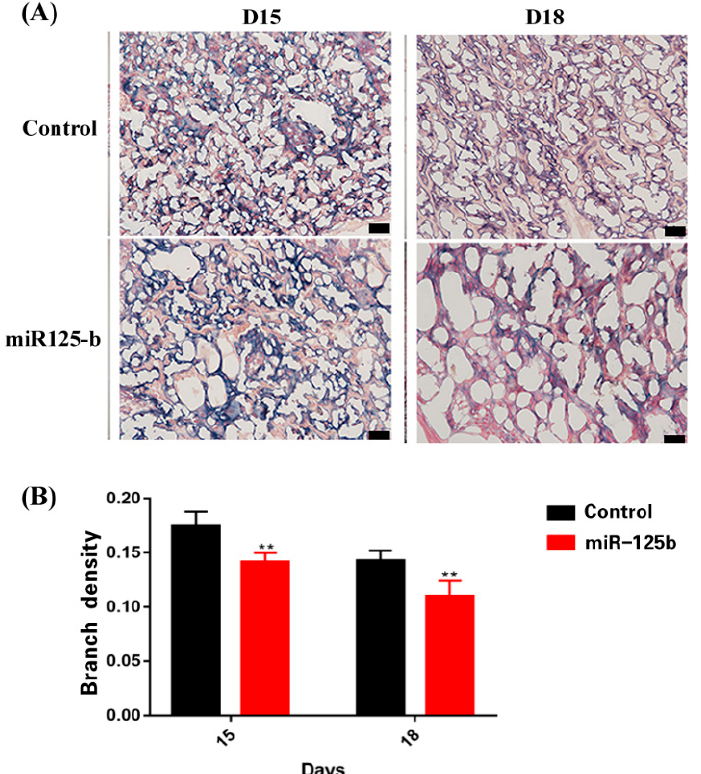
Figure 4. AP staining of placenta ( A ): AP staining of placenta on day 15 and 18. Scale bars: 500 μ m and 50 μ m; ( B ): Statistical analysis of the branch density compared with the control. Data are presented as mean ± SEM, n = 3, ** p < 0.01 vs. control.